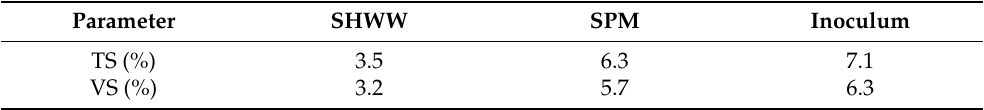
Table 2. Characteristics of substrates and